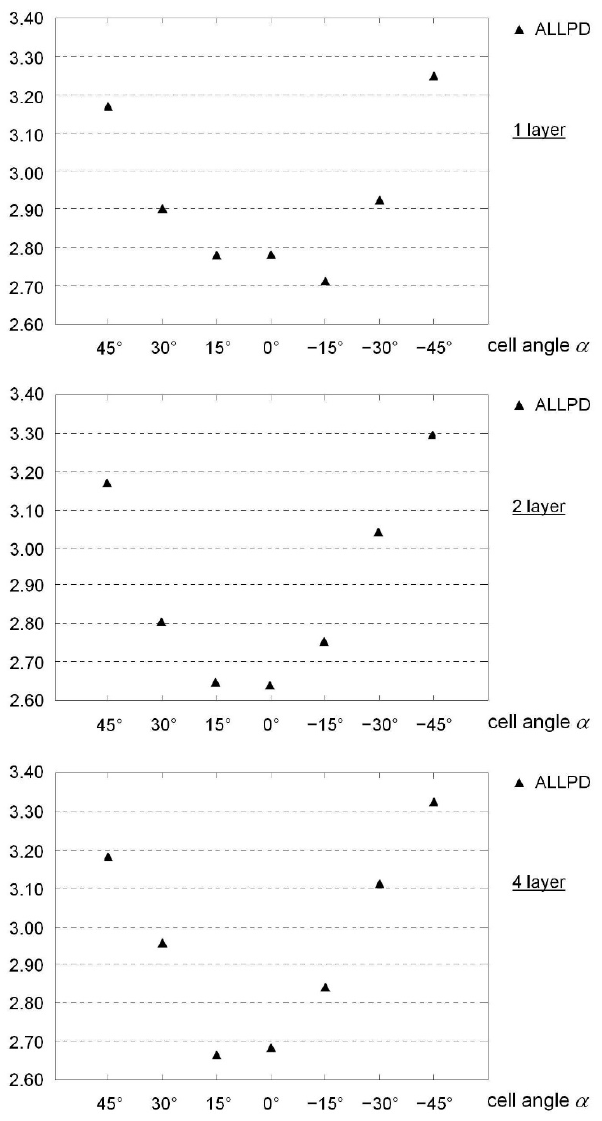
Figure 27. Three-dimensional lattice cores: normalized maximum values for plastic dissipation Figure 27. Three ‐ dimensional lattice cores: normalized maximum values for plastic dissipation en ‐ ergy.